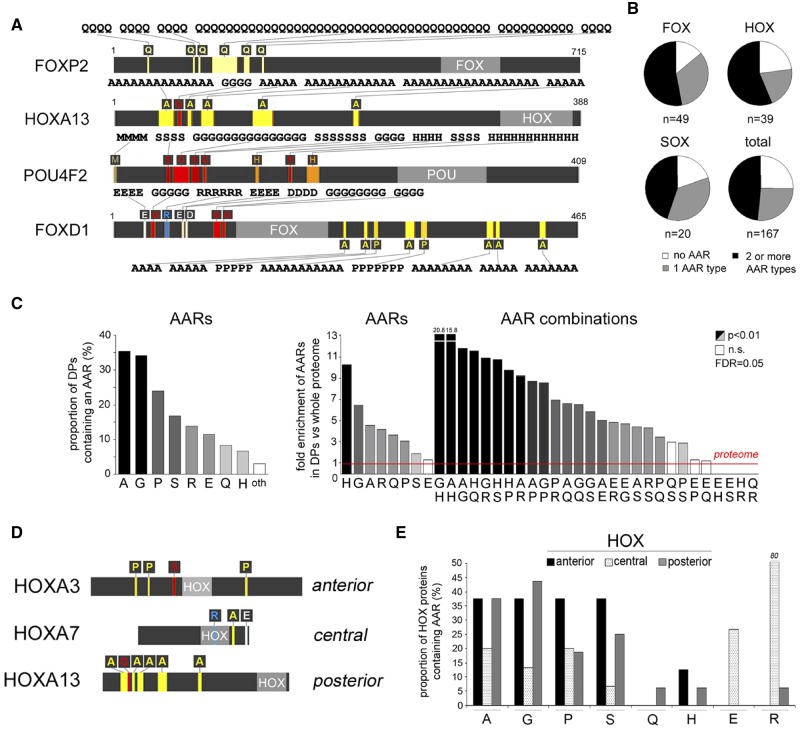
—Differential distribution of AARs and their pairwise combinations in HOX and other major DP families. (A) Schematic representation (gray bars) of selected human DPs. AARs are represented by colored stripes and one-letter amino acid symbols above/below each bar. AAR sequences are reported above/below the bars. Forkhead (FOX), homeobox (HOX), and POU domains are in light gray. The numbers on the right indicate the total number of residues in each protein. (B) Pie charts representing the proportion of proteins with no AAR, AARs of one amino acid only, or two/more, in the HOX, FOX, SOX families and in the whole set of 167 DPs. (C) The left histogram displays the percentage of proteins in the 167 DP set that contains the indicated AARs. The right histogram displays the fold enrichment of the indicated AARs, or their pairwise combinations, in the DP set in comparison with the whole proteome (red line). Abbreviations: p, P value; n.s., nonsignificant; FDR, Benjamini-Hochberg false discovery rate. (D) Schematic representation as in (A) of selected HOX proteins of the anterior, central, and posterior classes. The length of each bar is proportional to the protein length. (E) Histogram displaying the percentage of proteins in the anterior, central, and posterior classes of HOX proteins containing the indicated AARs.